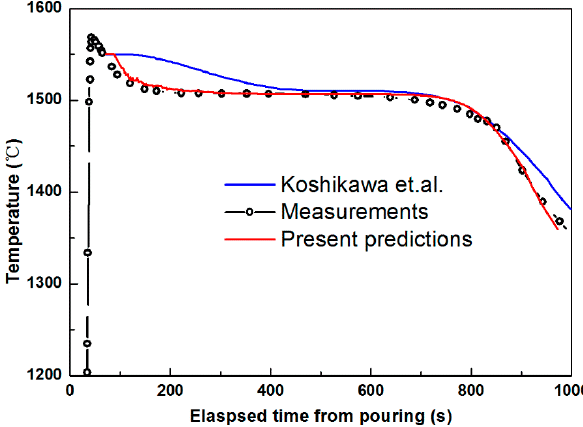
Figure 3. Comparison of the cooling history at the location of the thermocouple TC-1.